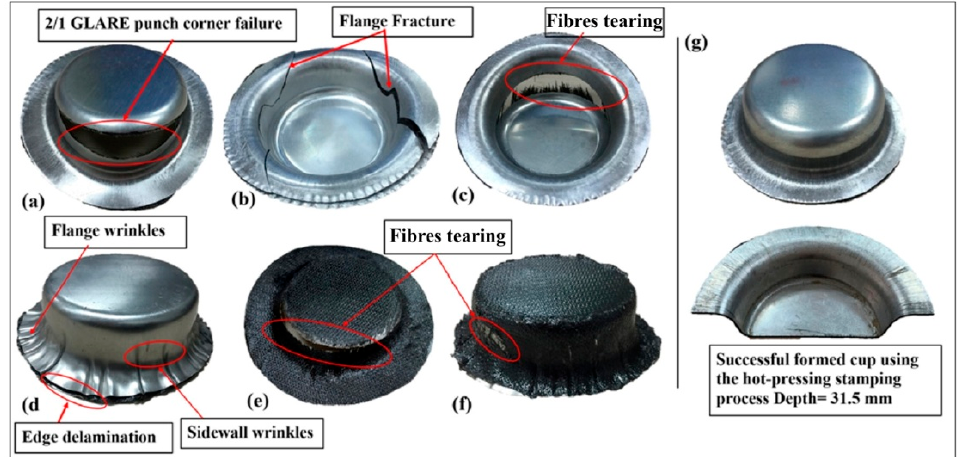
Figure 36. Failure types and locations: ( a ) punch corner fracture, ( b ) flange fracture, ( c ) fibre tearing and aluminium fracture, ( d ) sidewall and flange wrinkles, edge delamination, ( e , f ) tearing of glass fibre, ( g ) successfully formed cup using the new process proposed by Blala et al. [22] (reprinted with permission from [22]; copyright© 2021, The Author(s), under exclusive licence to Springer-Verlag London Ltd., part of Springer Nature).